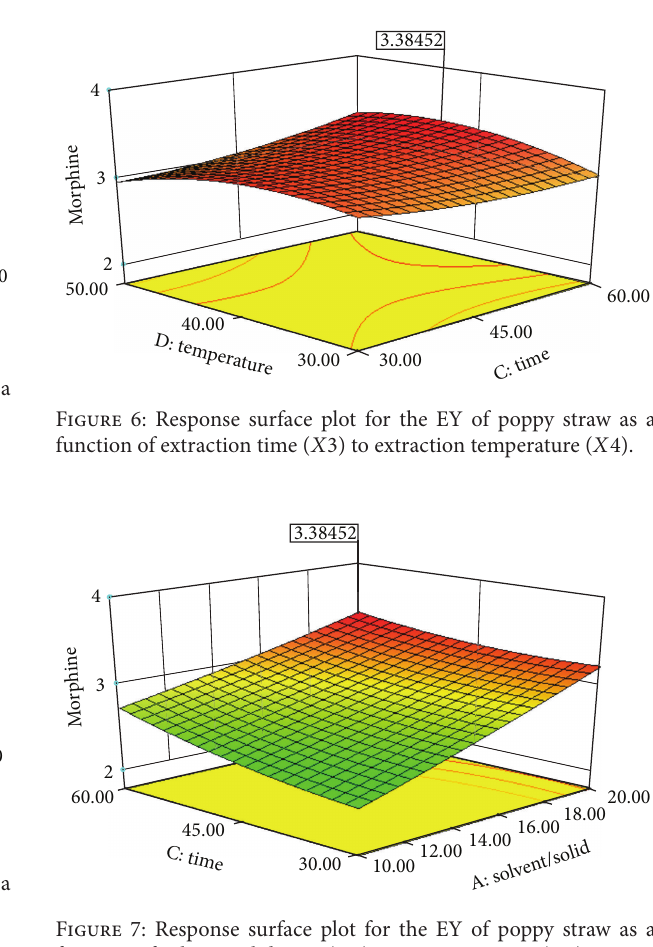
Figure 5: Response surface plot for the EY of poppy straw as a function of solvent/solid ratio ( 𝑋1 ) to extraction temperature ( 𝑋4 ).